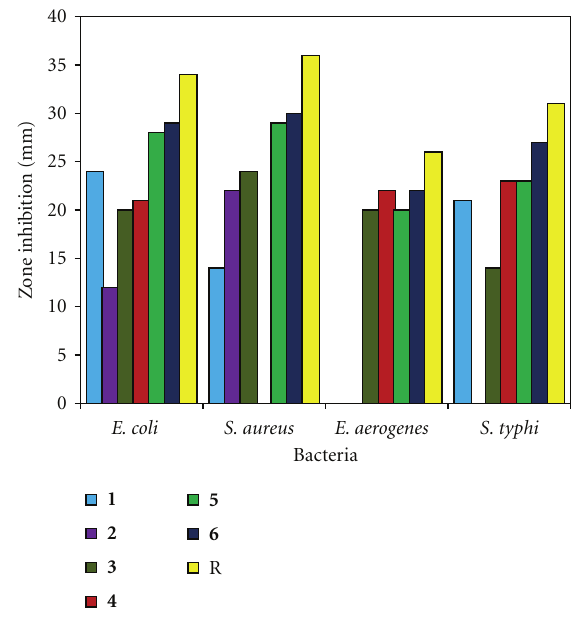
Figure 3: Antibacterial activity of compounds 1–6 against various